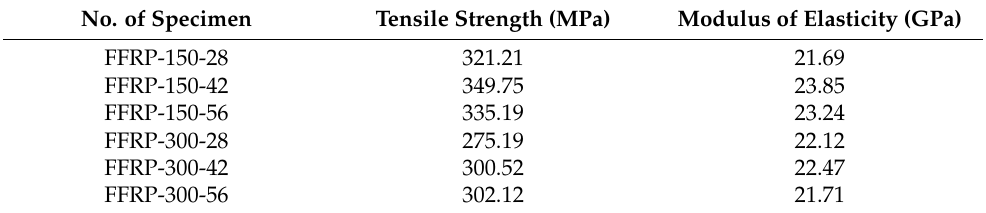
Figure 5. Setup for the split disk test: ( a ) specimens, and ( b ) test setup. Table 4. Results of FFRP split disk test .